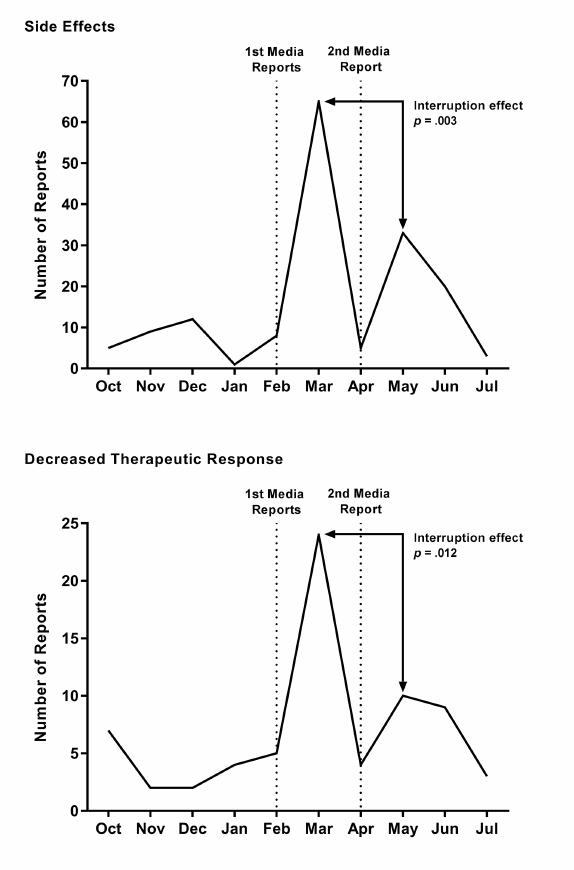
Figure 1. Number of reports of side effects and decreased therapeutic response before and after the media